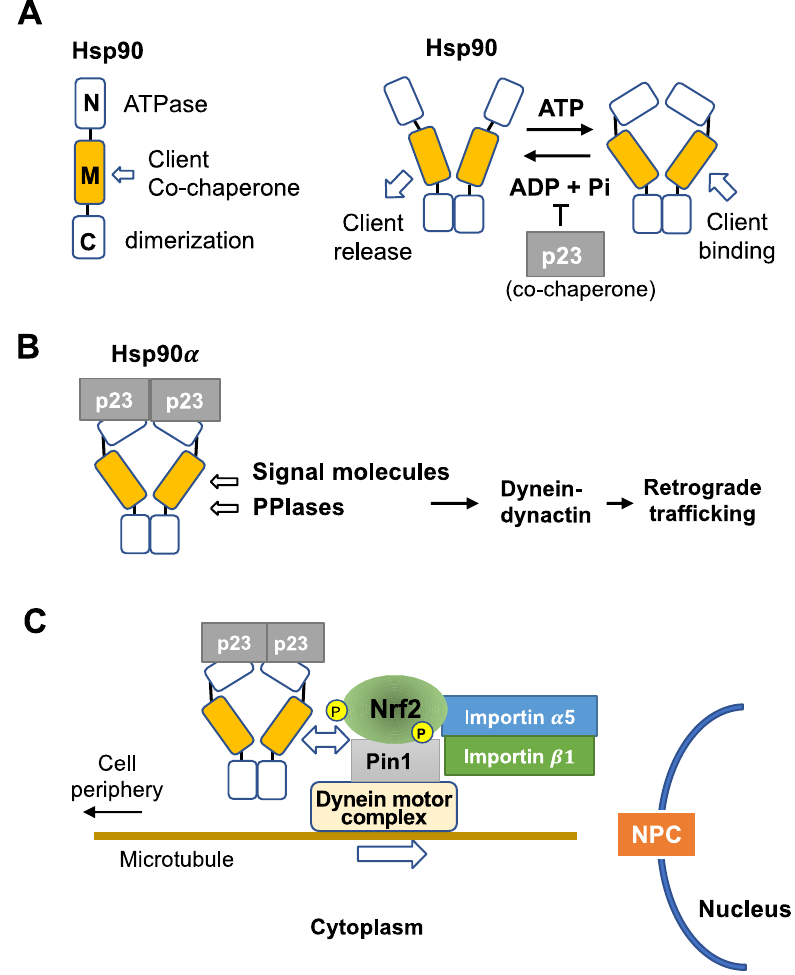
Figure 3. Proposed mechanism of Hsp90-mediated nuclear translocation of Nrf2. ( A ) Hsp90 is composed of three domains, an N-terminal domain with ATPase activity, a middle domain for binding co-chaperones and clients, and a C-terminal domain for dimerization. Hsp90 dimer takes two forms, e.g., open and ATP-bound closed ring forms. Co-chaperone p23 inhibits Hsp90 ATPase activity. ( B ) Hsp90 α dimer-p23 complex is the basal structure for transporting PPIase-associated signal molecules such as steroid receptors to the nucleus. ( C ) Hsp90 α -p23-Pin1-Nrf2-importin- α 5 β 1 containing complex associates with a dynein motor complex, which carries the cargo toward the nuclear pore complex (NPC) along microtubules.